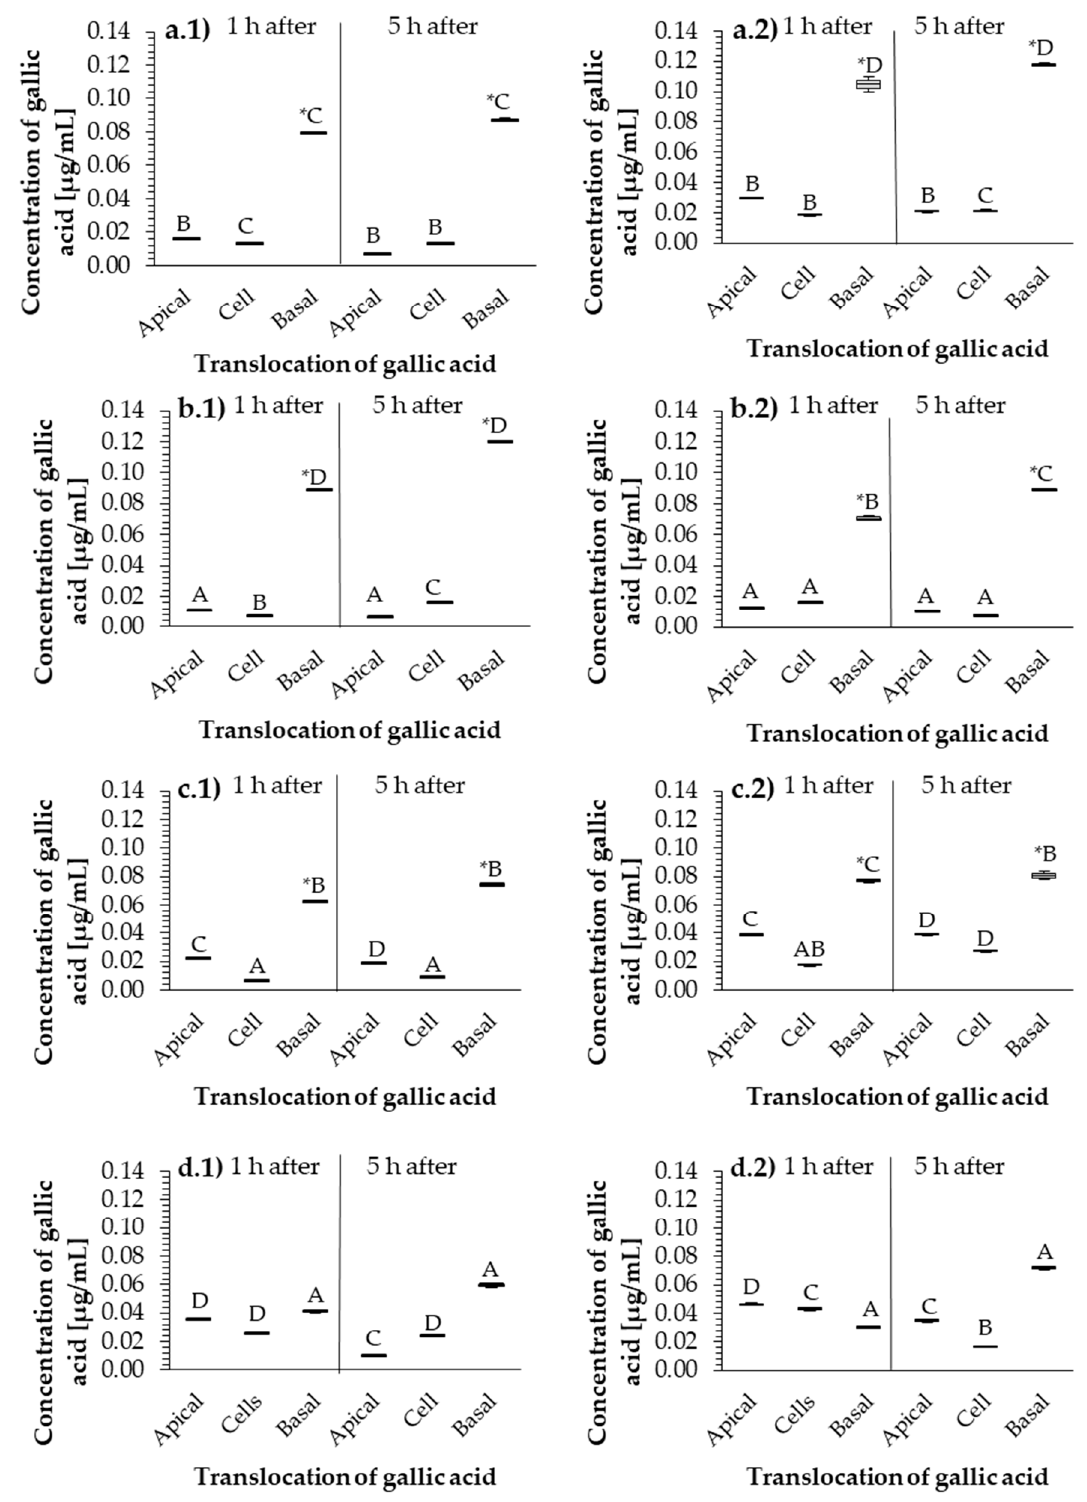
Figure 4. Transport of gallic acid in the presence of ( a ) Tanex, ( b ) Farmatan, ( c ) Contan, and ( d ) gallic acid through PSI cells after 1 and 5 h incubation, and exposed to 12 µg/mL (first column, ( a1 – d1 )) and 37 µg/mL (second column, ( a2 – d2 )). Samples were collected from apical, cell, and basal (basolateral) compartments of the 3D cell model. Capital letters represent statistically significant differences within the same cell compartment between HT tannins at p ≤ 0.05. * represents a statistically significant difference between parts of the cell model within a single time interval at p ≤ 0.05.